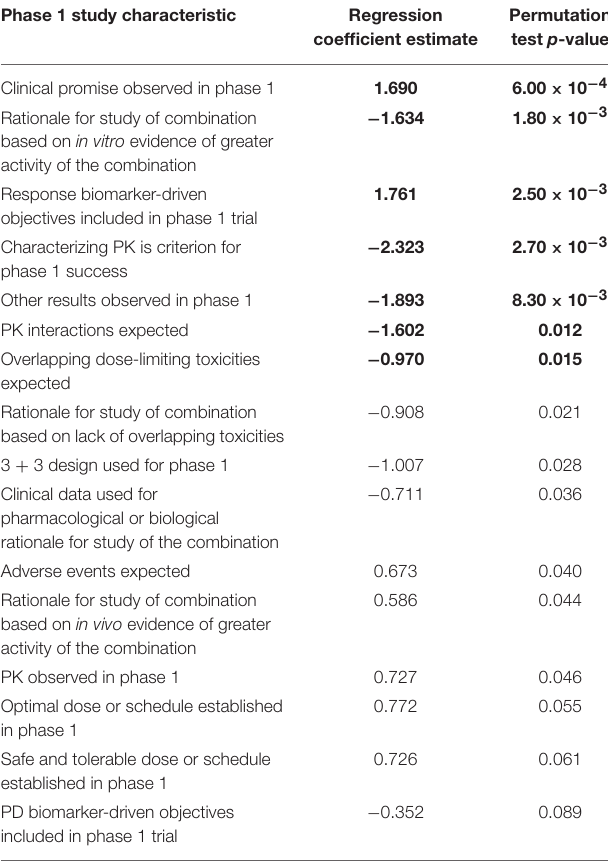
TABLE 6 | Regression coefficient estimates and permutation test p -values of the multivariate model of probability of achieving each milestone given the phase 1 study